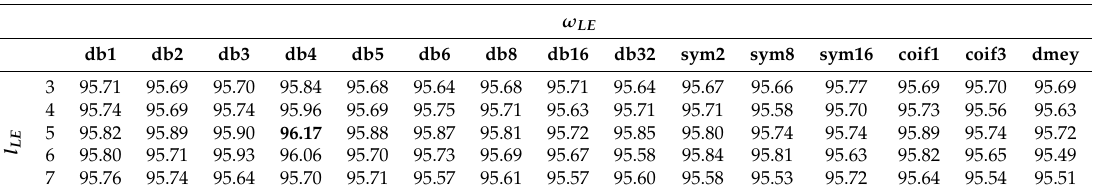
Table 15. The accuracy (%) of two class sleep stage classification with different ω LE and l LE under R&K standard.